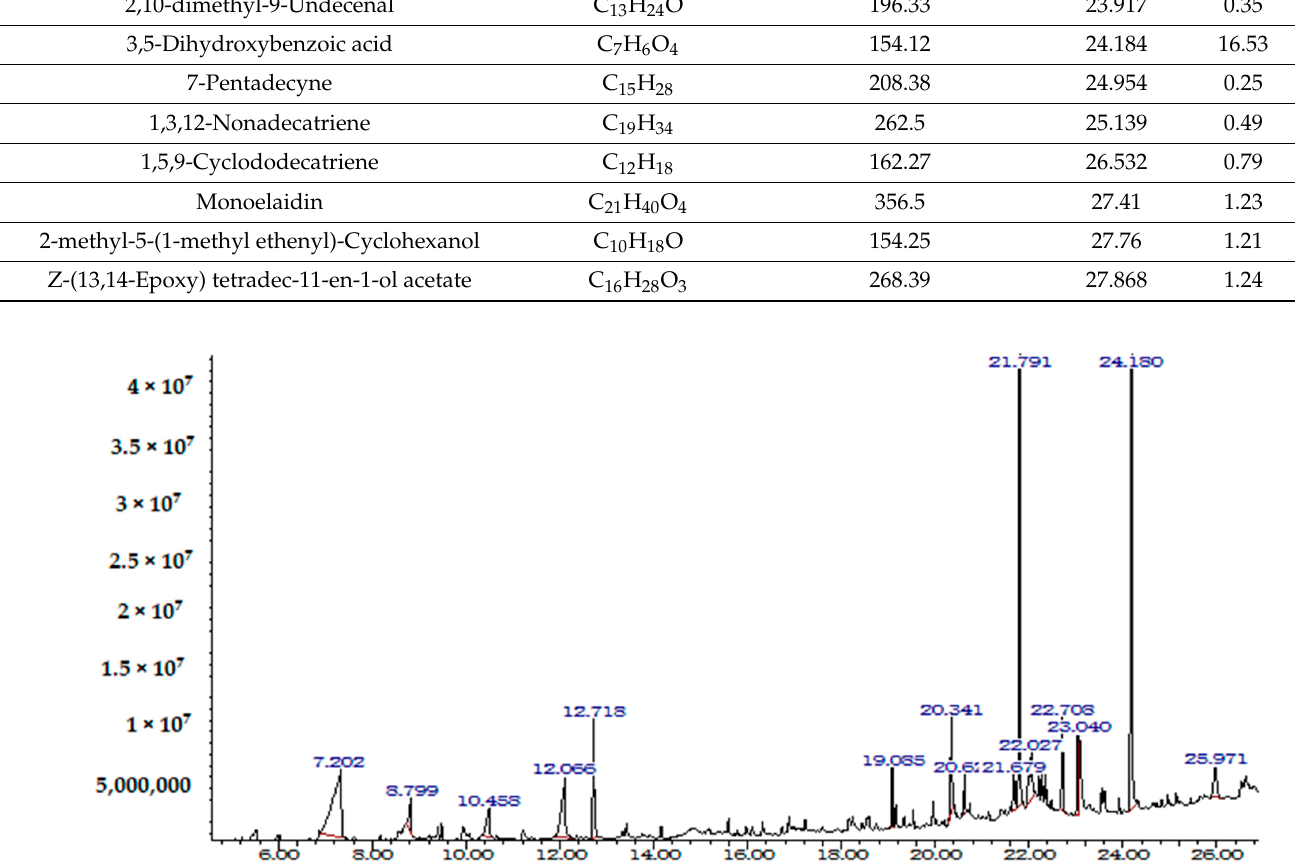
Figure 6. GC-MS chromatogram of D. innoxia ethanolic extract.